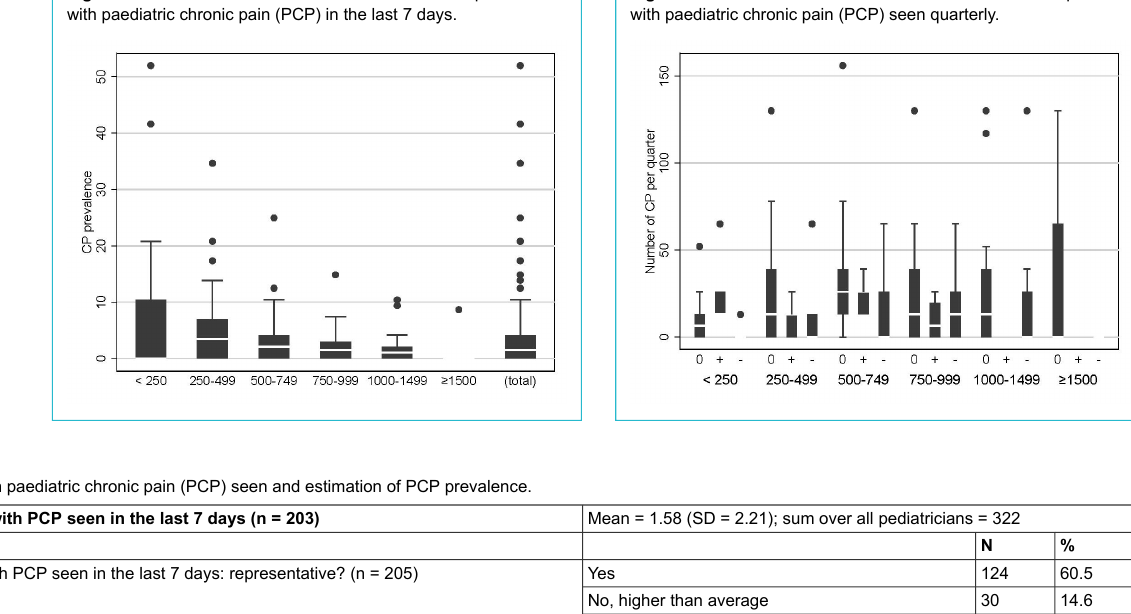
Figure 2: Monte Carlo simulation based on the number of patients with paediatric chronic pain (PCP) seen quarterly.